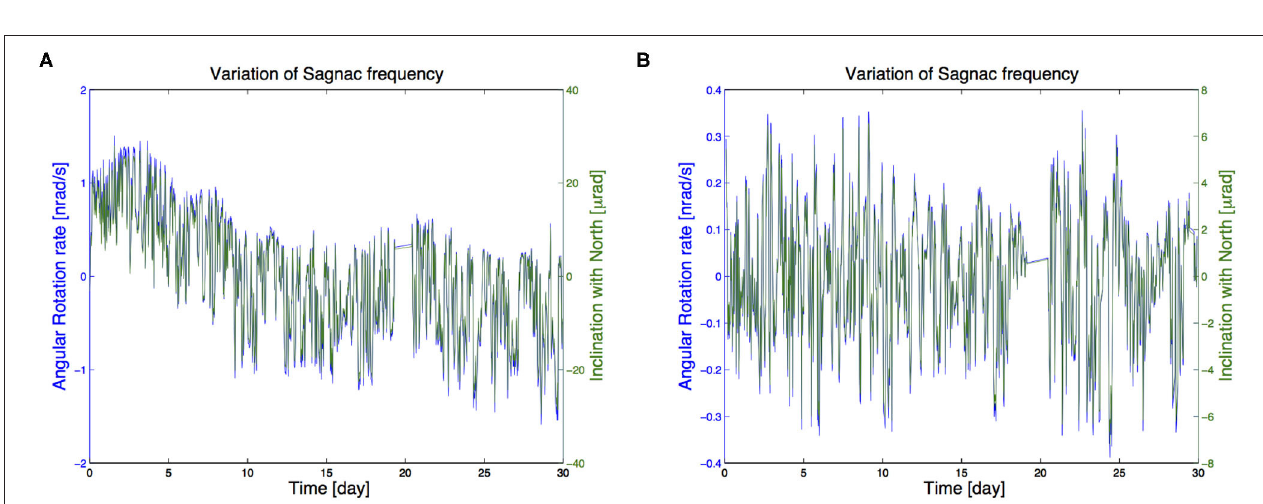
FIGURE 8 | (A) The data utilized in the present analysis (30 days from June 15, 2018), ω s 0 with mean subtracted, and the data after around day 20 have been removed since GINGERINO was in split mode. (B) ω s , mean subtracted, evaluated with the model of the laser systematic. The data have been decimated down to 1,800s. Since GINGERINO is a single-ring gyroscope, with an 45 ◦ inclination with the Earth axis, it is impossible to distinguish rotations and inclinations. On the ∼ right, the sensitivity is expressed in change of the relative angle with the Earth rotation axis, showing that the orientation of the apparatus of GINGERINO is stable at the level of a few µ